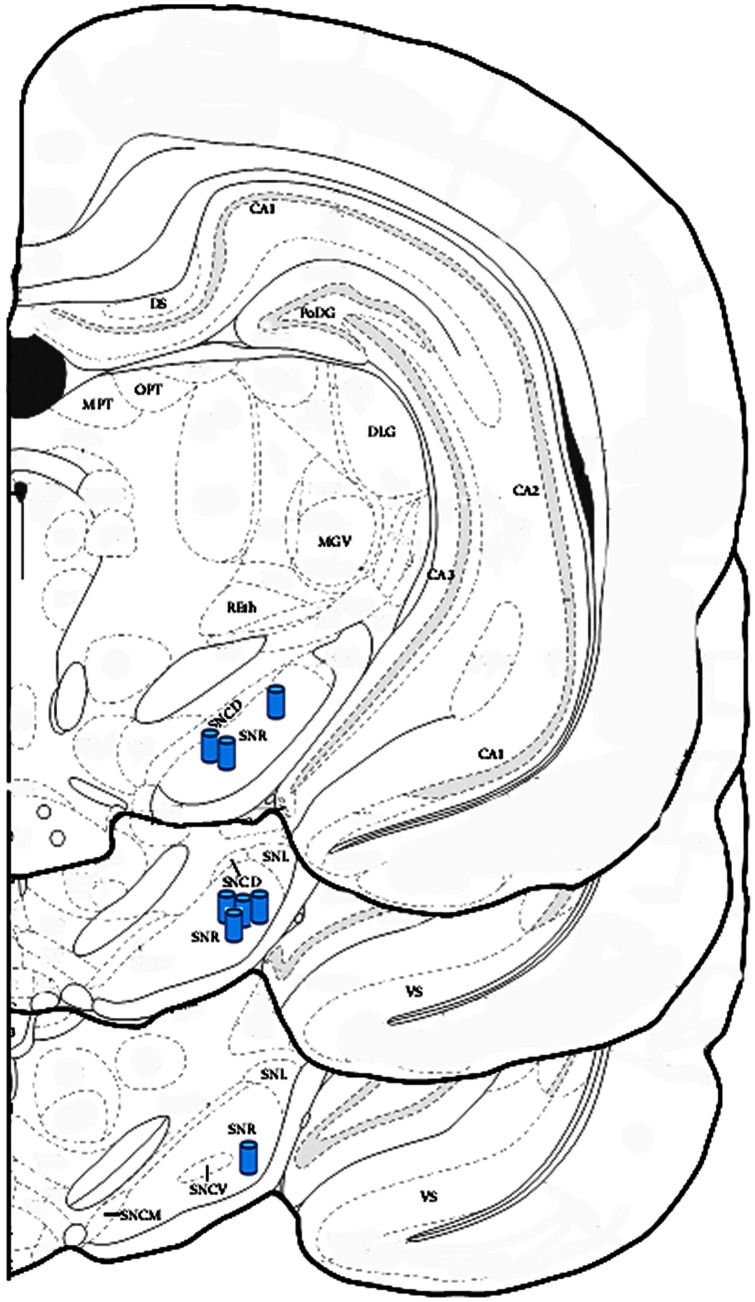
Schematic drawing placement of injectors for the mice receiving drugs (blue cylinders) in the left substantia nigra.